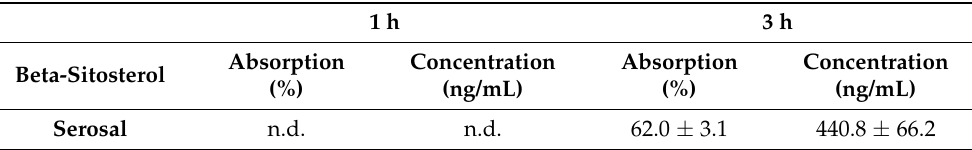
Table 4. Beta-sitosterol bioavailability and cellular accumulation following intestinal epithelium exposure to LENILUTS ® for 1 and 3 h. Results are expressed as percentage of absorption and concentration (mean ± standard deviation). N.d.: not